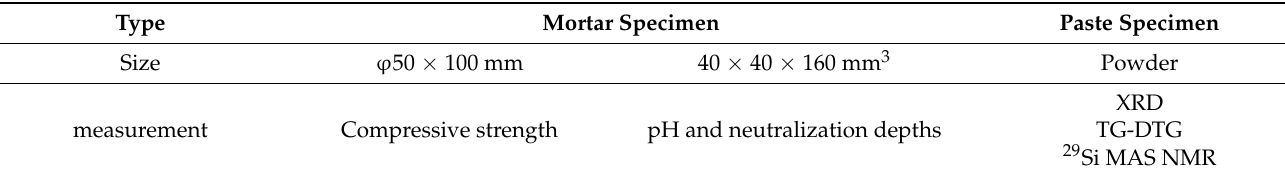
Table 4. Measurement